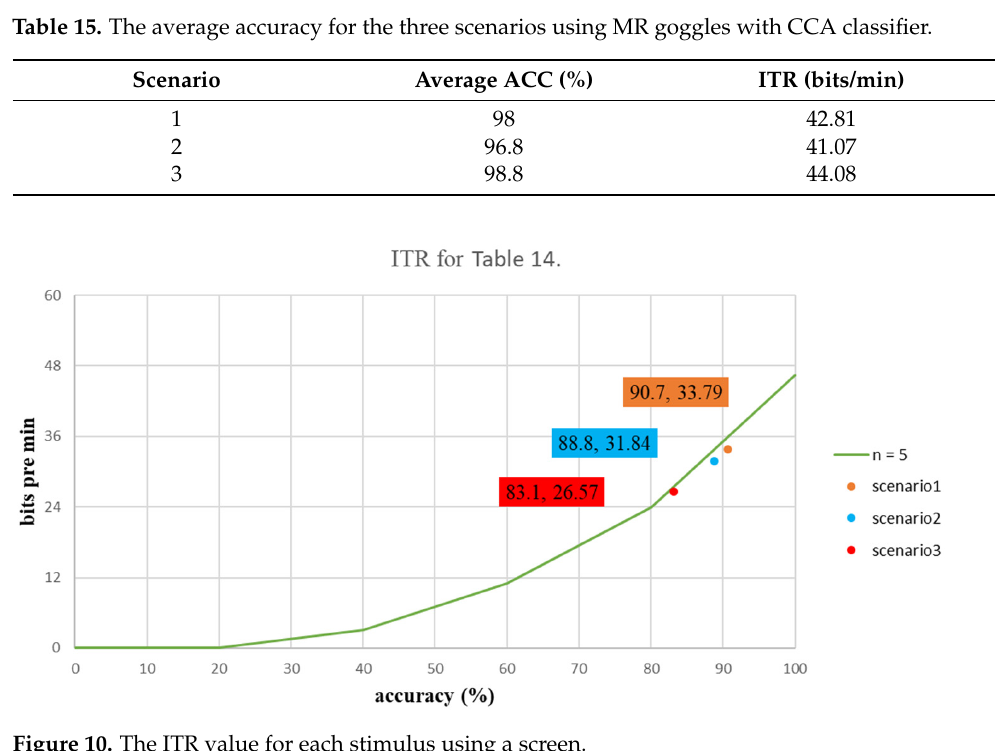
Figure 10. The ITR value for each stimulus using a screen.